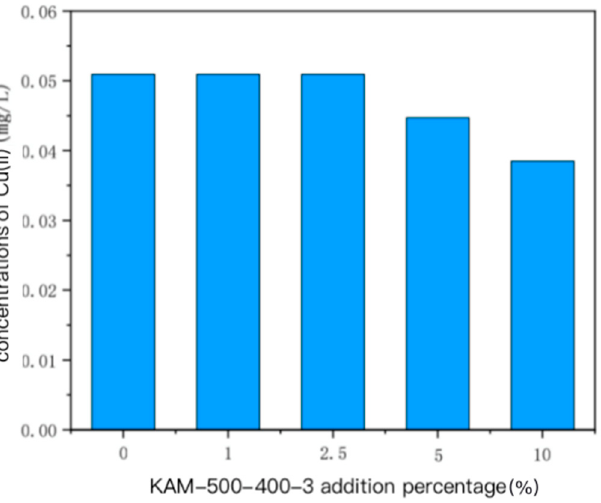
Figure 3. Effect of KAM-500-400-3 addition percentage on the concentrations of Cu(II) in the pore water of single Cu(II)-contaminated sediment.